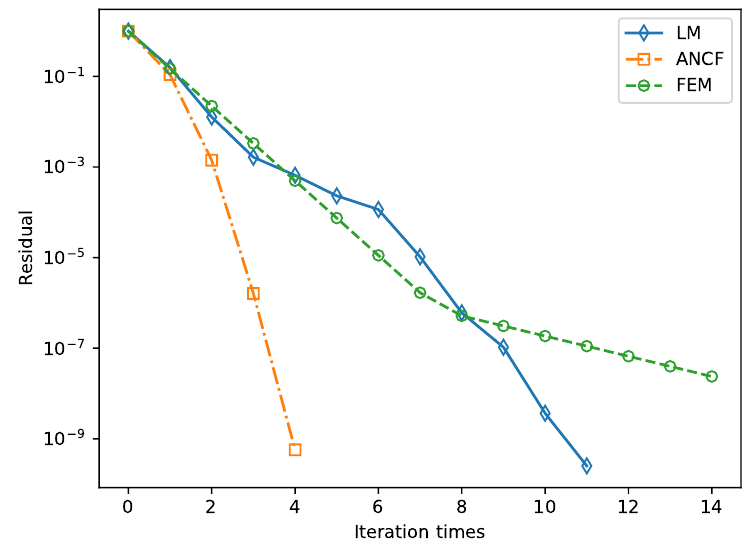
Figure 14. Relative value of the calculation